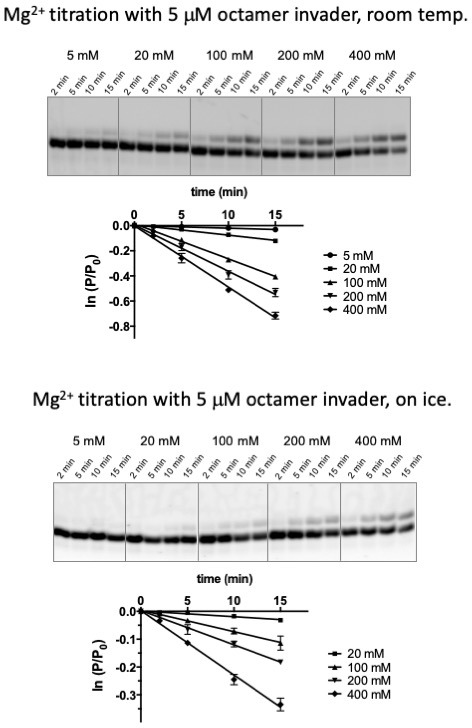
Representative denaturing PAGE data and plots of ln(P/P0) vs. time for the reaction kinetics with an octamer invader, as described in Figure 3.